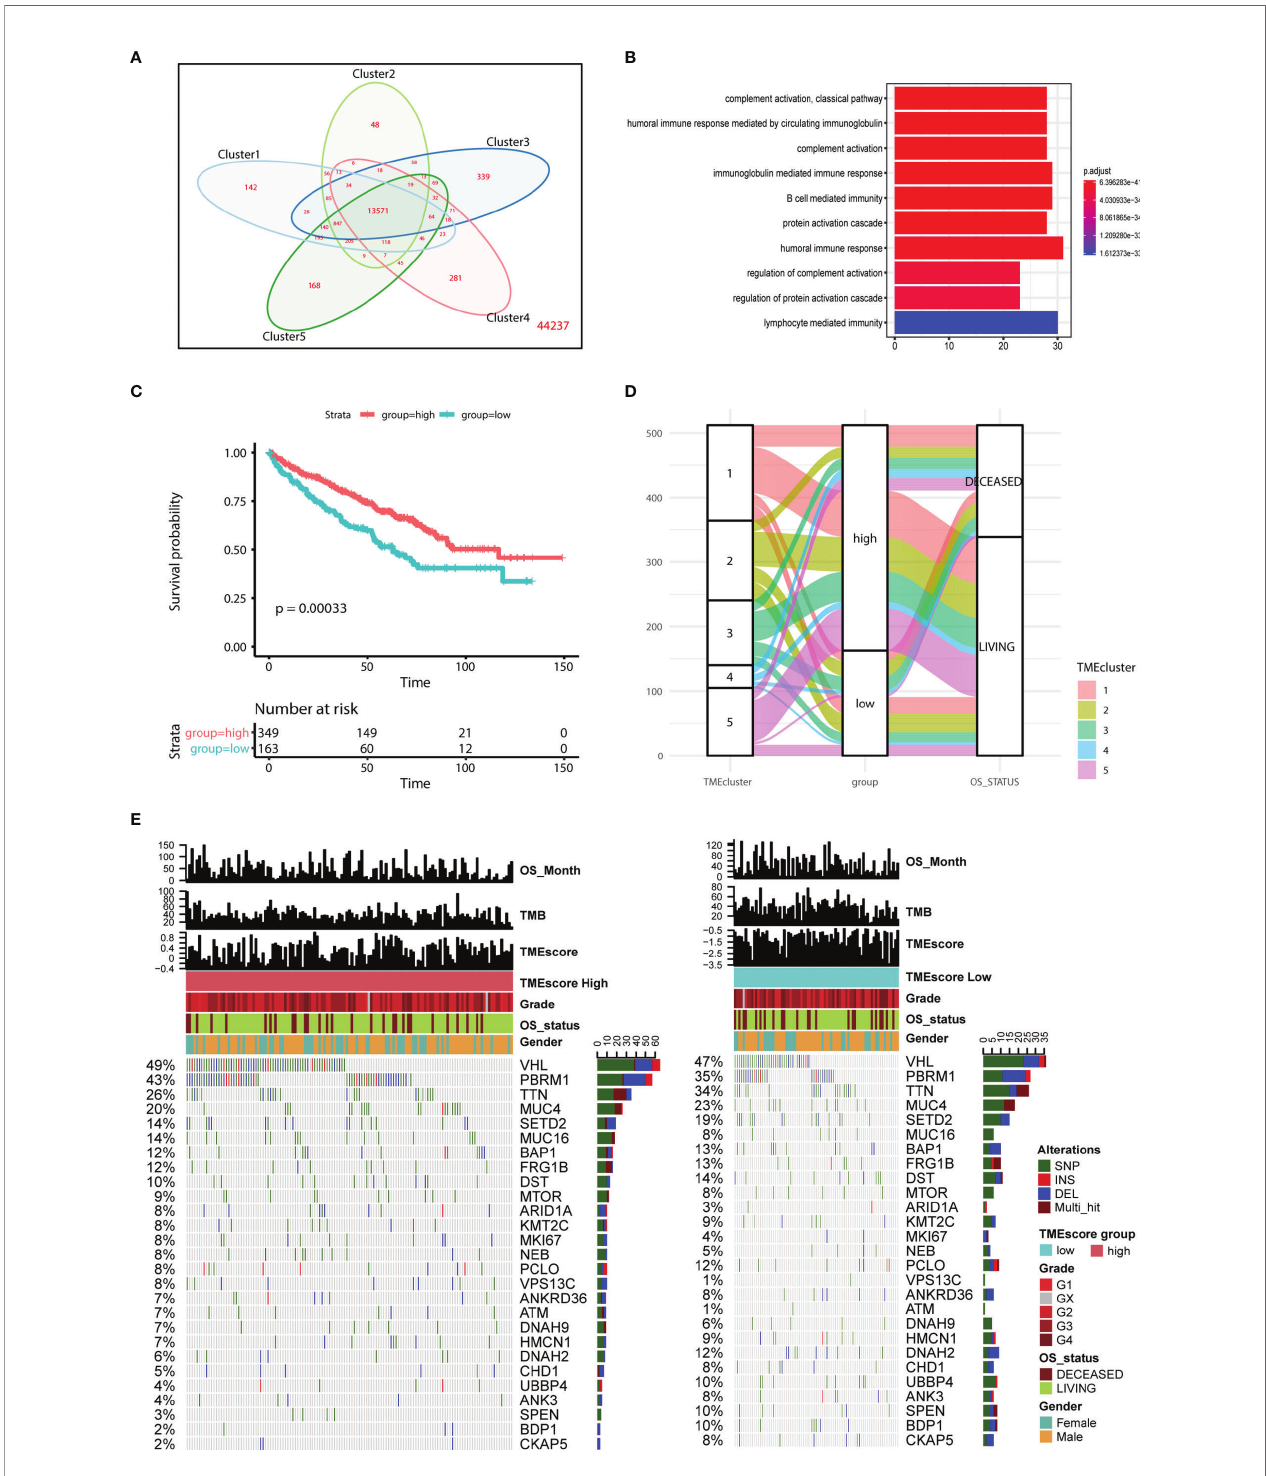
FIGURE 4 | Construction of TMEscore and integrative analysis in TME. (A, B) Venn diagram showed the totally 13571 intersected genes, in which functional enrichment analysis indicates the genes might be involved in B cell mediated immunity, humoral immune response, lymphocyte medicated immunity and other cancer-related immune crosstalk. (C, D) Kaplan-Meier analysis and mulberry map indicate the patients in low TMEscore group correlate with poor survival outcomes (log-rank test, P < 0.001). (E) Mutated pro fi les of top variant genes correlated with TMEscore. Single nucleotide variants: dark green, InDel (insertion or deletion): red, frameshift: blue, Multi_hit: brown. TMEscores, TCGA molecular subtypes, TMEscore, gender, and overall survival status are shown as speci fi c